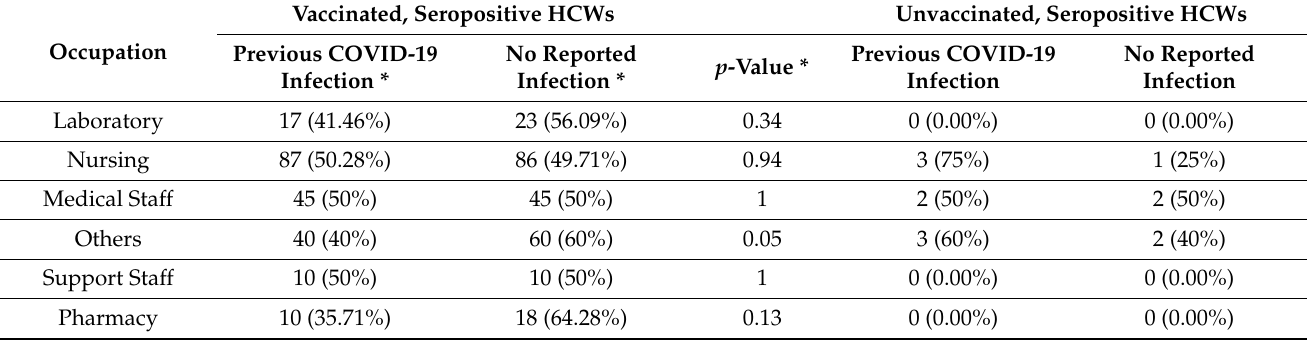
Table 7. The seroconversion rates among vaccinated and unvaccinated HCWs according to their occupation with a history of COVID-19 infection at any time prior to the time of